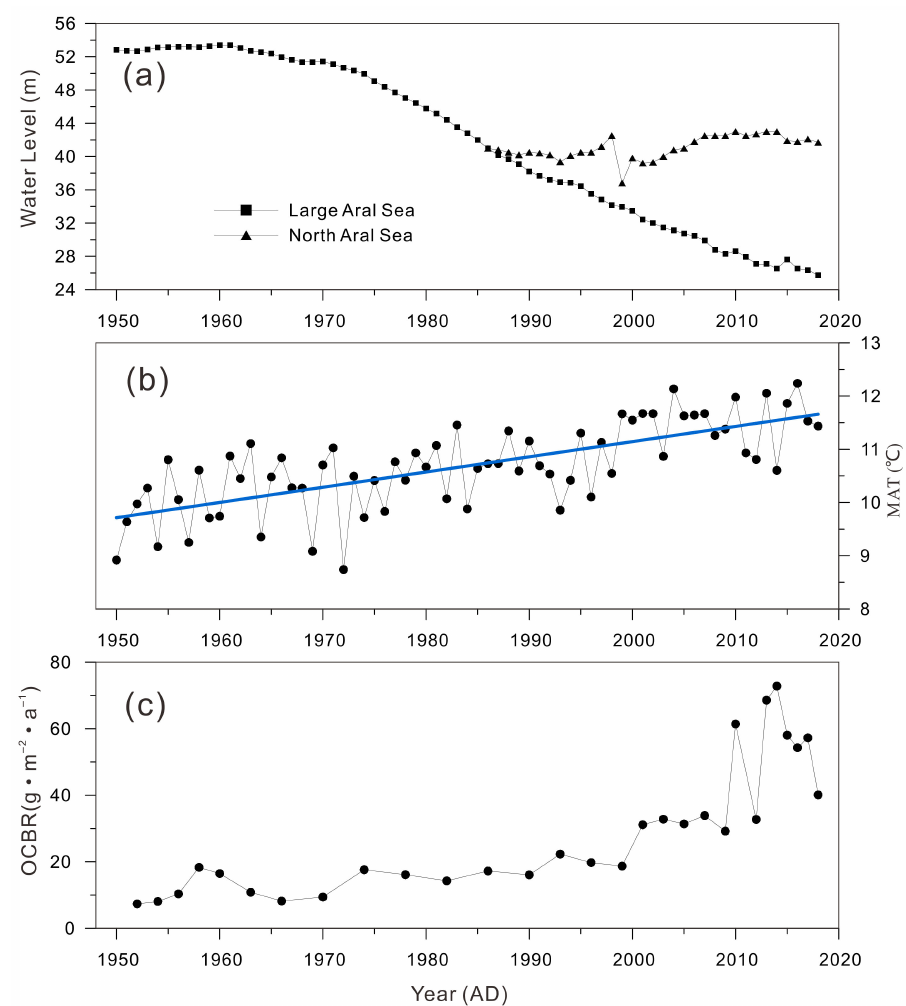
Figure 4. The water level changes of the Aral Sea ( a ) compared with ( b ) the mean annual temperature (MAT) of the Aral Sea Basin (the blue line is for linear fitting), and ( c ) the evolution of the organic carbon burial rate (OCBR) of lake sediments from the North Aral Sea from 1950 to 2020. Note: This figure is original; the water level data (1960–2018) in ( a ) was sourced from the reference [58], and the water level data (1950–1960) were from [59]; the data for ( b ) were also shown in Figure 2 with the same data